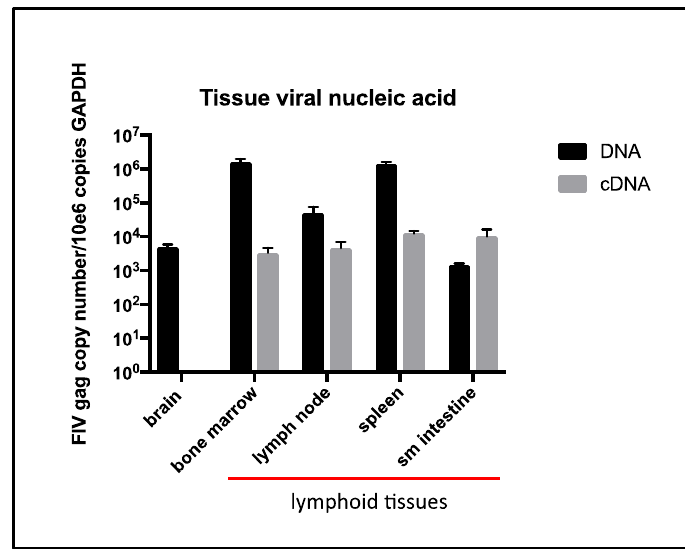
Figure 5. Proviral DNA (black bars) is detectable by real-time PCR in all of the examined feline tissues while vRNA (cDNA, grey bars) is only detectable in lymphoid tissues (red line).